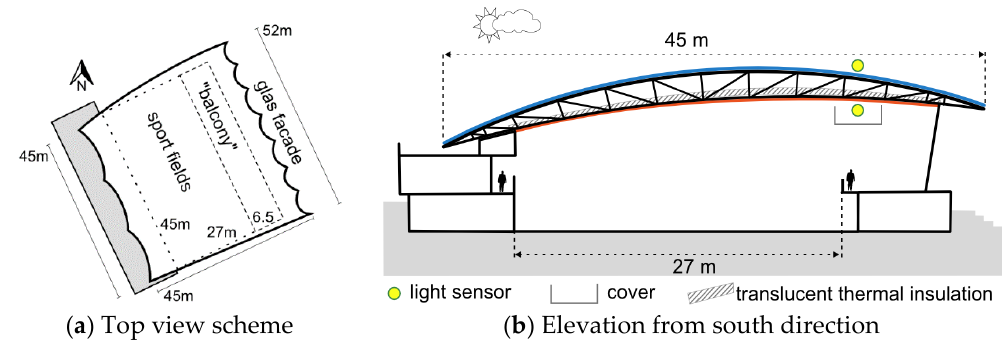
Figure 2. ( a ) Scheme of the top view; and ( b ) elevation from south direction of the complete building. The sensor positions of the short time measurements of the illuminance are indicated.